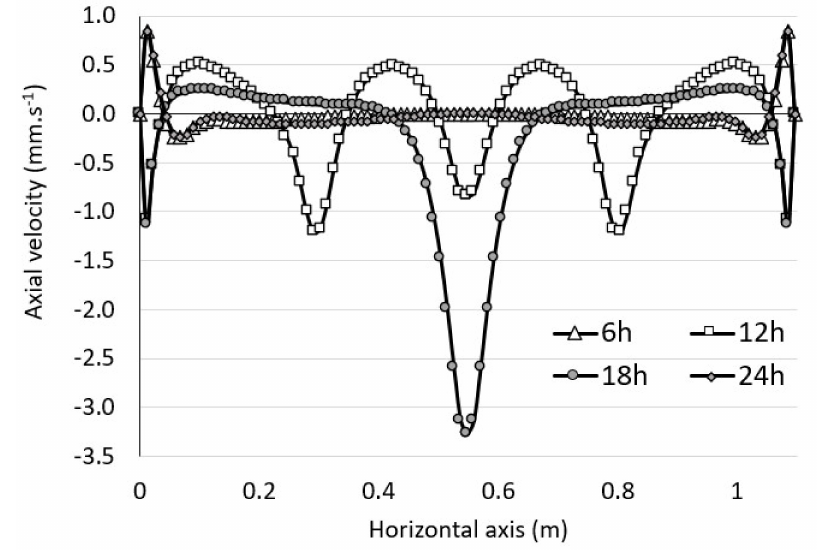
Figure 8. Axial velocity of the wine at 6, 12, 18 and 24 h, respectively, as plotted along a horizontal axis at y = 210